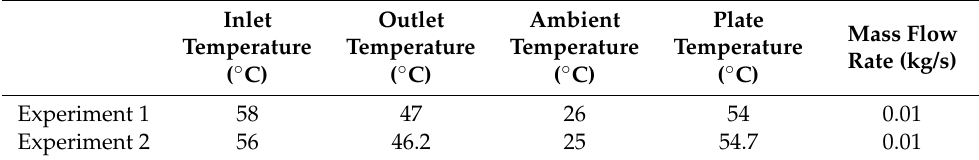
Table 3. Temperature measurements in the laboratory for heat loss calculations.